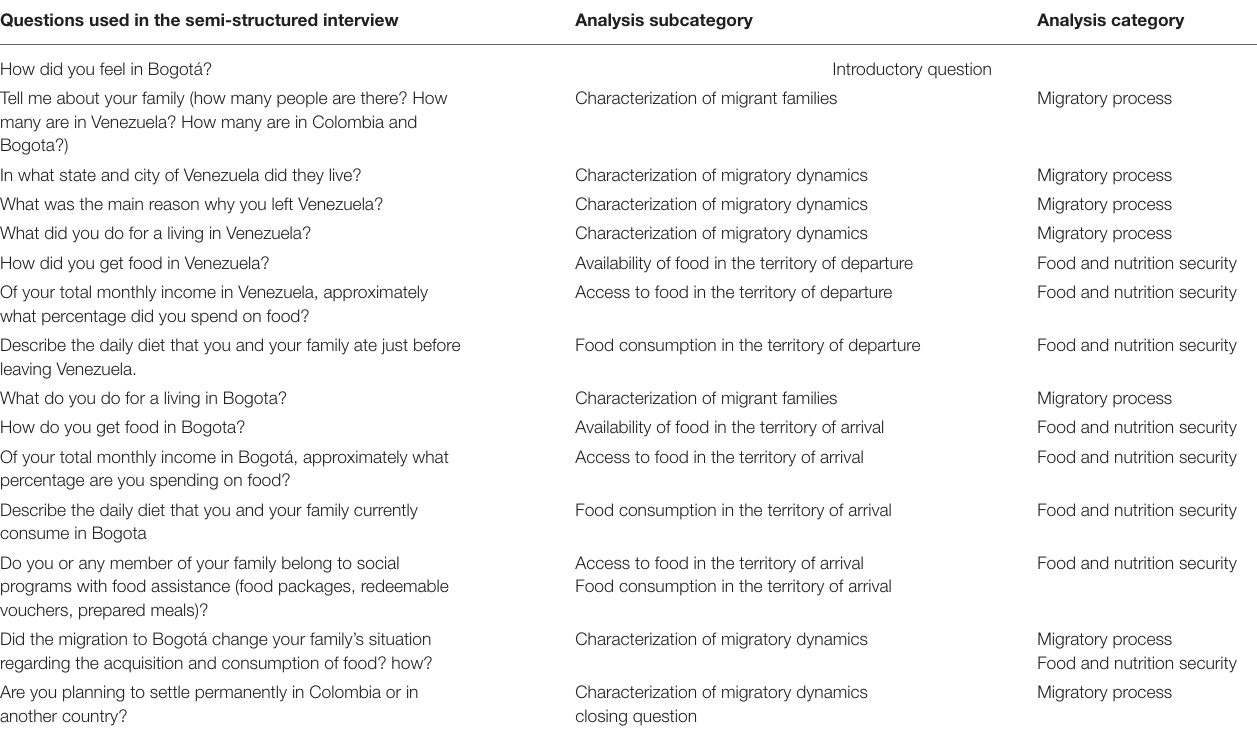
TABLE 1 | Semi-structured interview and categories of